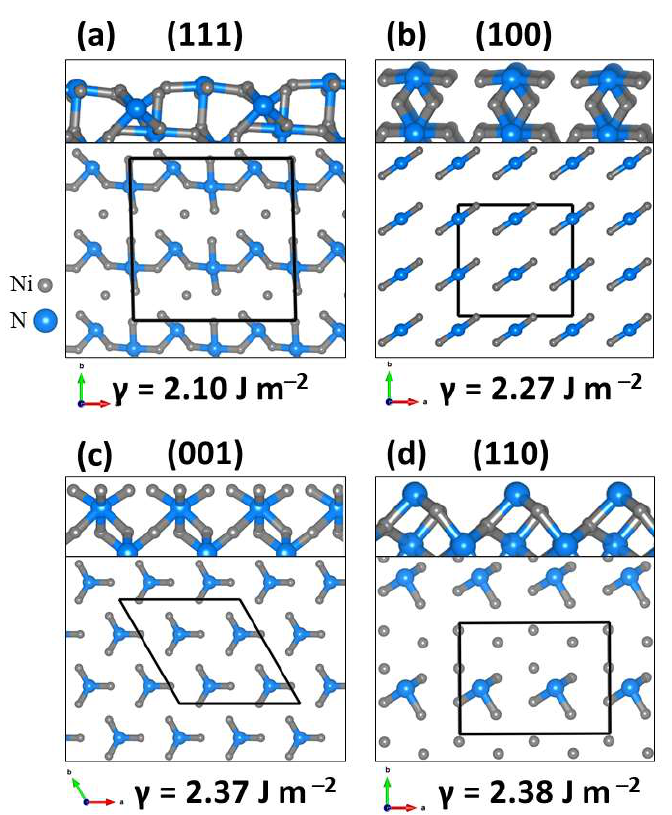
Figure 2. Side and top views of ( a ) Ni 3 N(111), ( b ) (100), ( c ) (001), and ( d ) (110) surface terminations. Listed below each are the respective surface energies (γ).